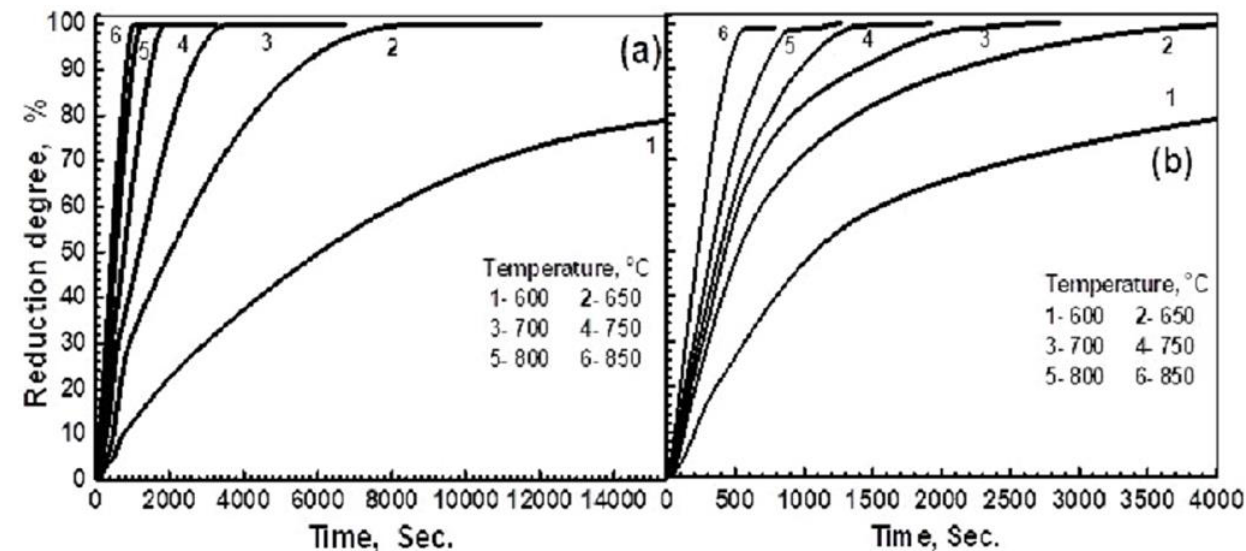
Figure 3. Isothermal reduction behavior of precursors with H 2 at 600–850 °C; ( a ) precursor A; and ( b ) precursor B.